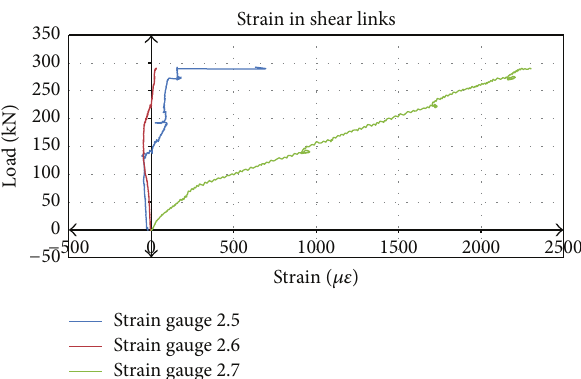
Figure 30: Strain readings recorded on shear links.